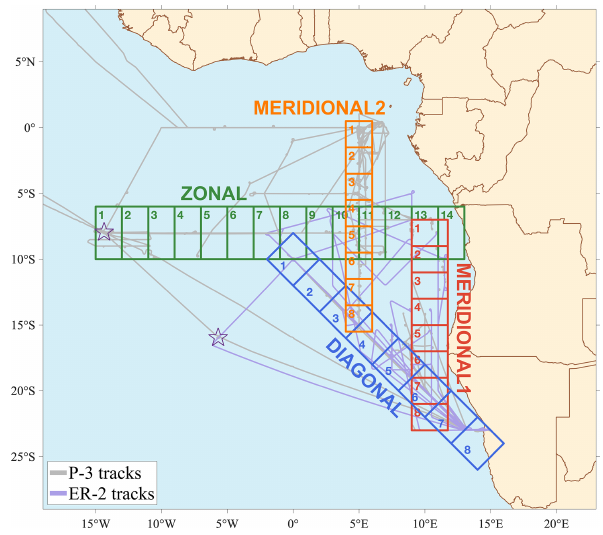
Figure 1. The four transects used in the model–observation com- parison are shown along with the P-3 (2016, 2017, and 2018) and ER-2 (2016) aircraft flight tracks. Grid boxes within each transect are numbered from north–west to south–east. See Table S1 in the Supplement for the grid box coordinates. The locations of Ascen- sion Island (8 ◦ S, 14 ◦ W) and St. Helena island (16 ◦ S, 6 ◦ W) are indicated with